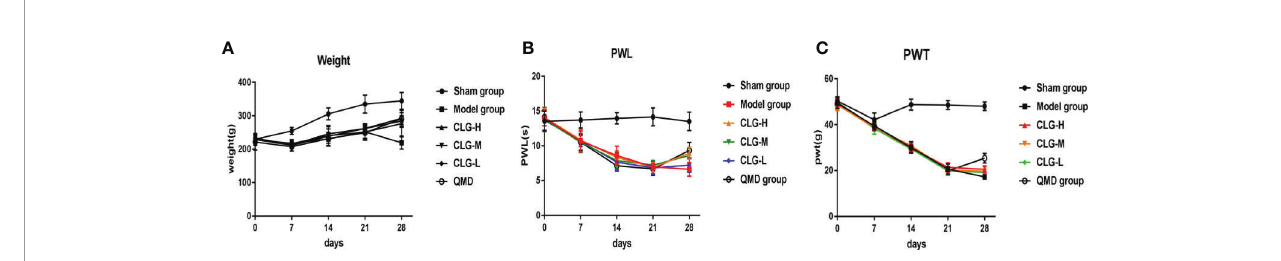
FIGURE 2 | Effect of CLG on body mass, the paw withdrawal latency to heat stimulation (PWL) and the paw withdrawal threshold to mechanical stimulation (PWT) in the CIBP rat model. (A) Growth curve of body weight of rats in each group (n=6). (B) The PWL of rats in each group (n = 6). (C) The PWT of rats in each group (n=6). In the model group, the PWL and PWT were decreased on the 7th, 14th, and 21st day following surgery, and no signi fi cant changes were noted in the sham group. On day 21 of administration, and 7 days following administration, the PWL and PWT were increased in the CLGH, CLGM, CLGL, and QMD groups and the model control group indicated a continuous decrease, whereas the sham group indicated no signi fi cant